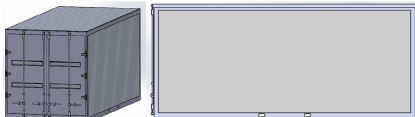
Figure 1: A 20-foot shipping